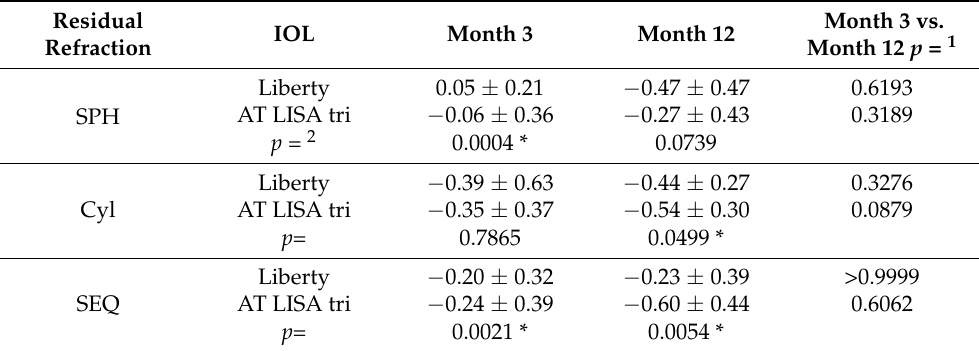
Table 1. Postoperative residual spherical (SPH), cylindrical (Cyl) and spherical equivalent (SEQ) refractions measured 3 and 12 months postoperatively. Data are presented as mean ±